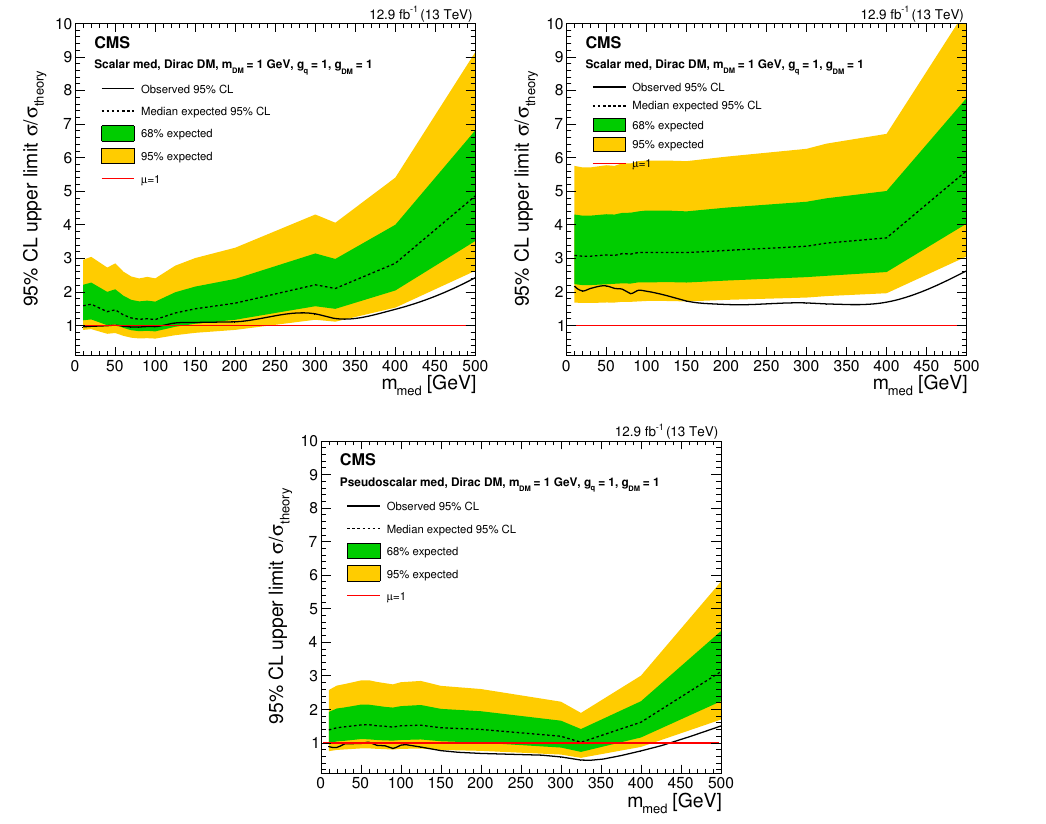
Figure 10 . Expected (dotted black line) and observed (solid black line) 95% CL upper limits on the signal strength (cid:22) as a function of the mediator mass for the spin-0 models. The horizontal red line denotes (cid:22) = 1. Limits for the scalar model on the combined cross section of the monojet and mono-V processes (upper left). Limits for the scalar (upper right) and pseudoscalar (bottom) models, respectively, assuming only the monojet signal process.